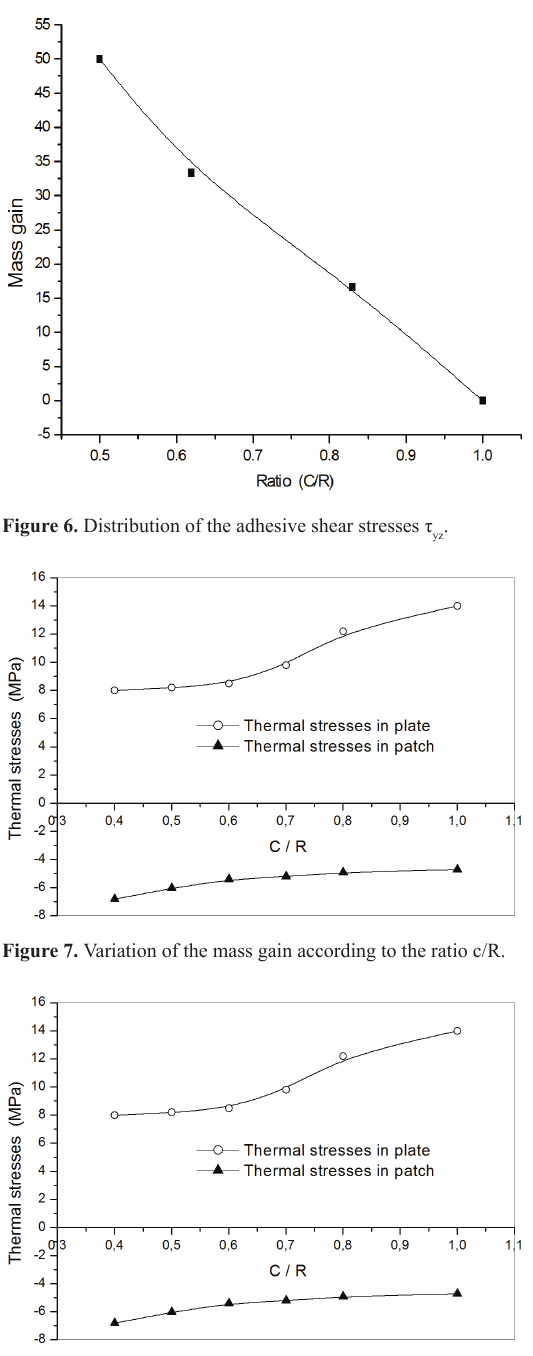
Figure 8. Maximal thermal stresses vs ratio